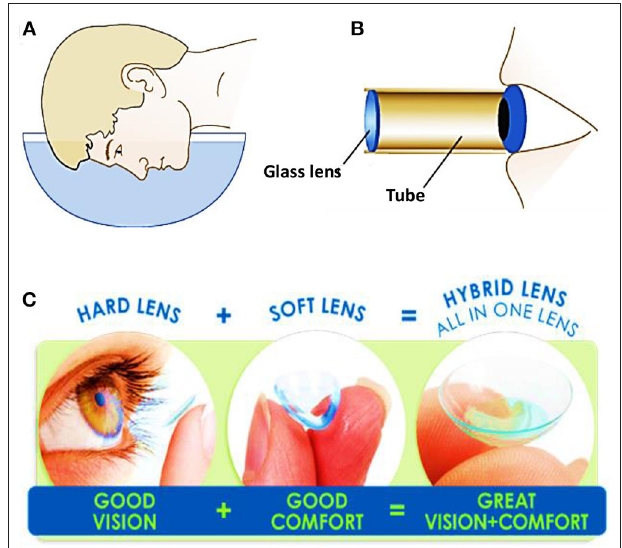
FIGURE 1 | Schematics showing the proposed methods for vision correction: (A) Leonardo da Vinci concept: a man looking through a bowel filled of water, and (B) René Descartes concept: a man looking through a tube filled with fluid. (C) Categories of contact lenses based on the constituents